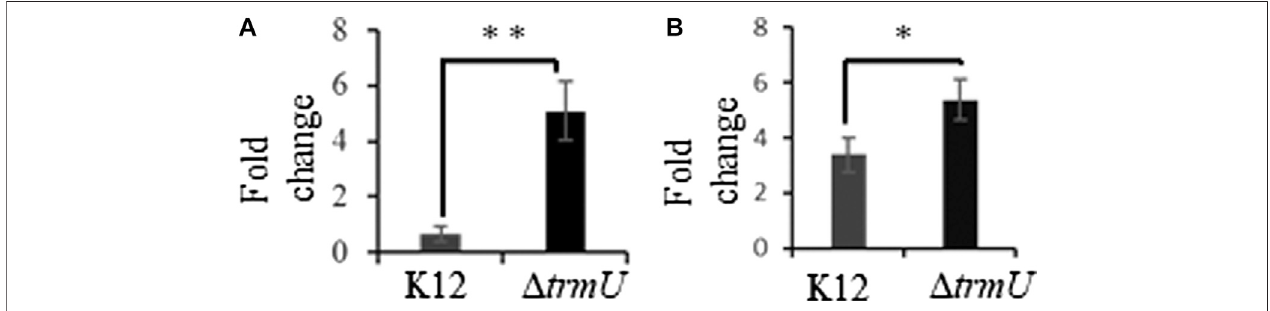
FIGURE 5 | Fold change of 8-oxo-rG in transfer RNA (A) and total RNA (B) following exposure of K12 and Δ trmU strains of E. coli to Fenton reaction-induced oxidative stress. Data are shown as the mean of 3-5 biological replicates samples ± SD. Statistical differences were determined using unpaired two-tailed t -test (* p < 0.05; ** p <